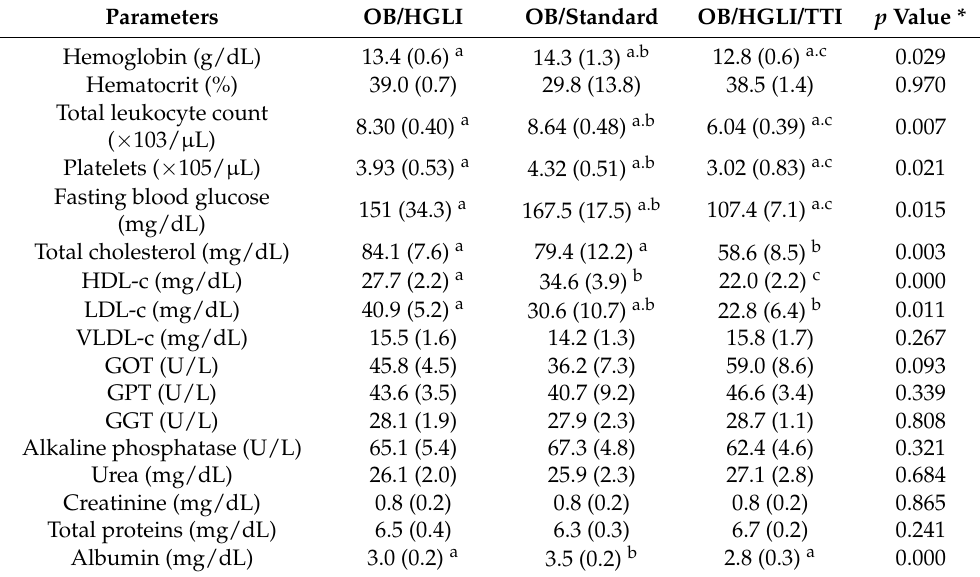
Table 2. Hematological and biochemical parameters of Wistar rats with obesity induced by HGLI diet, after ten days of